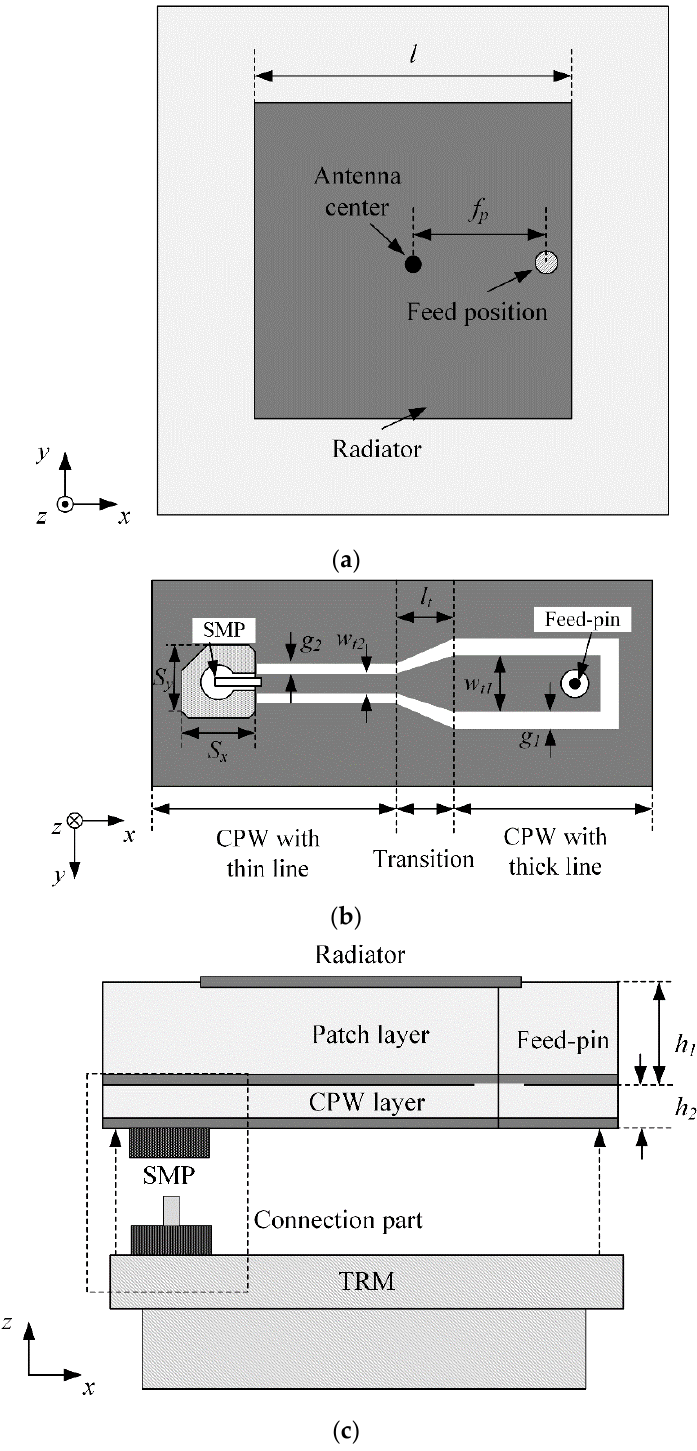
Figure 1. Geometry of the X ‐ band patch antenna with the CPW layer: ( a ) top view; ( b ) bottom view; ( c ) side view.